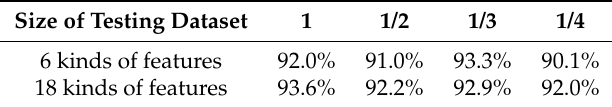
Table 6. Results under different size of testing